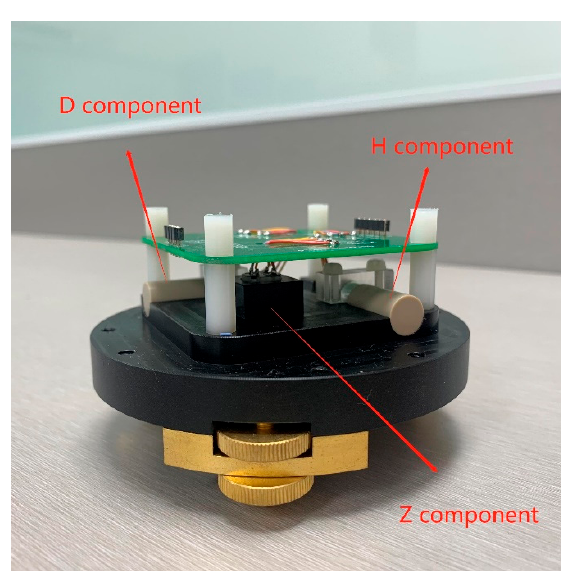
Figure 8. Location of the three probes.